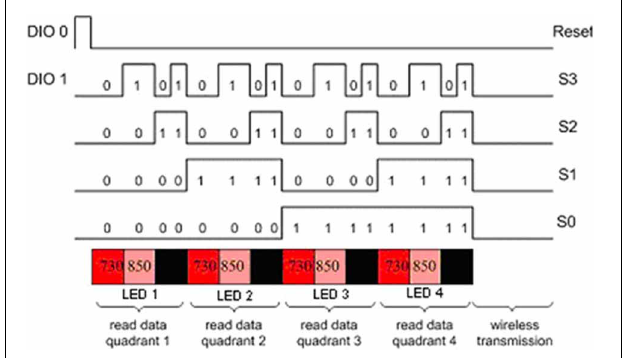
FIGURE 9 | Timing diagram of the control circuit.